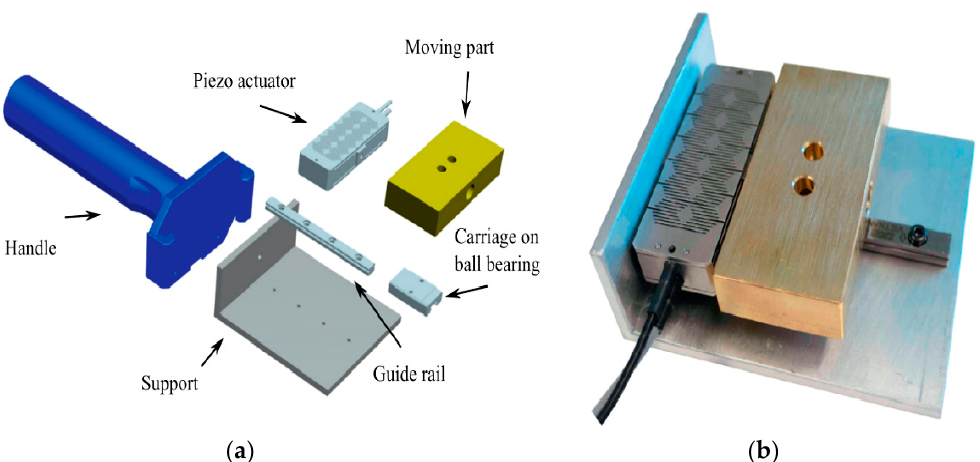
Figure 10. Three-dimensional model of the presented ungrounded tactile device with the main components highlighted ( a ) and the assembled device without the handle ( b ) [69].